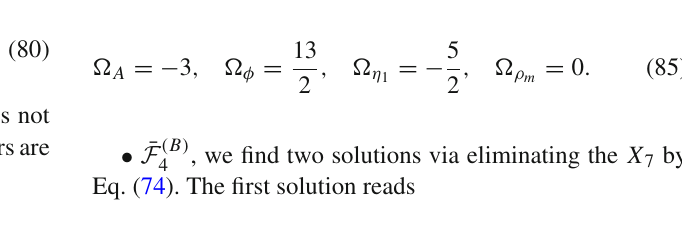
Fig. 9 On the left panel, the graph a shows the stability of the F ( D ) critical point. The saddle critical points lie in the red shaded region while non-shaded region is forbidden for critical points. On the right panel, the graph b illustrates the relation between density parameter